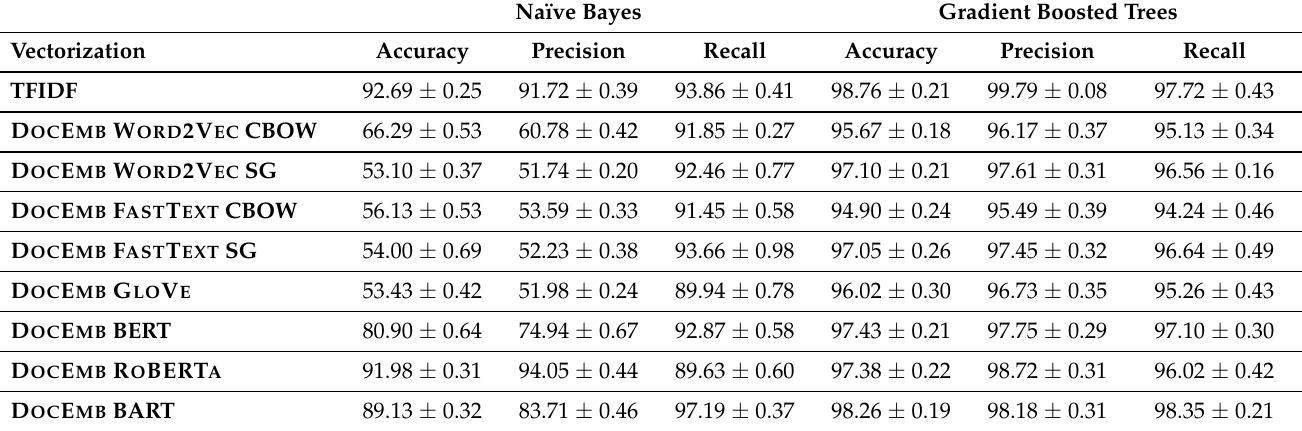
Table 2. Fake news detection results on the sample extracted from the Fake News Corpus. Naïve Bayes Gradient Boosted